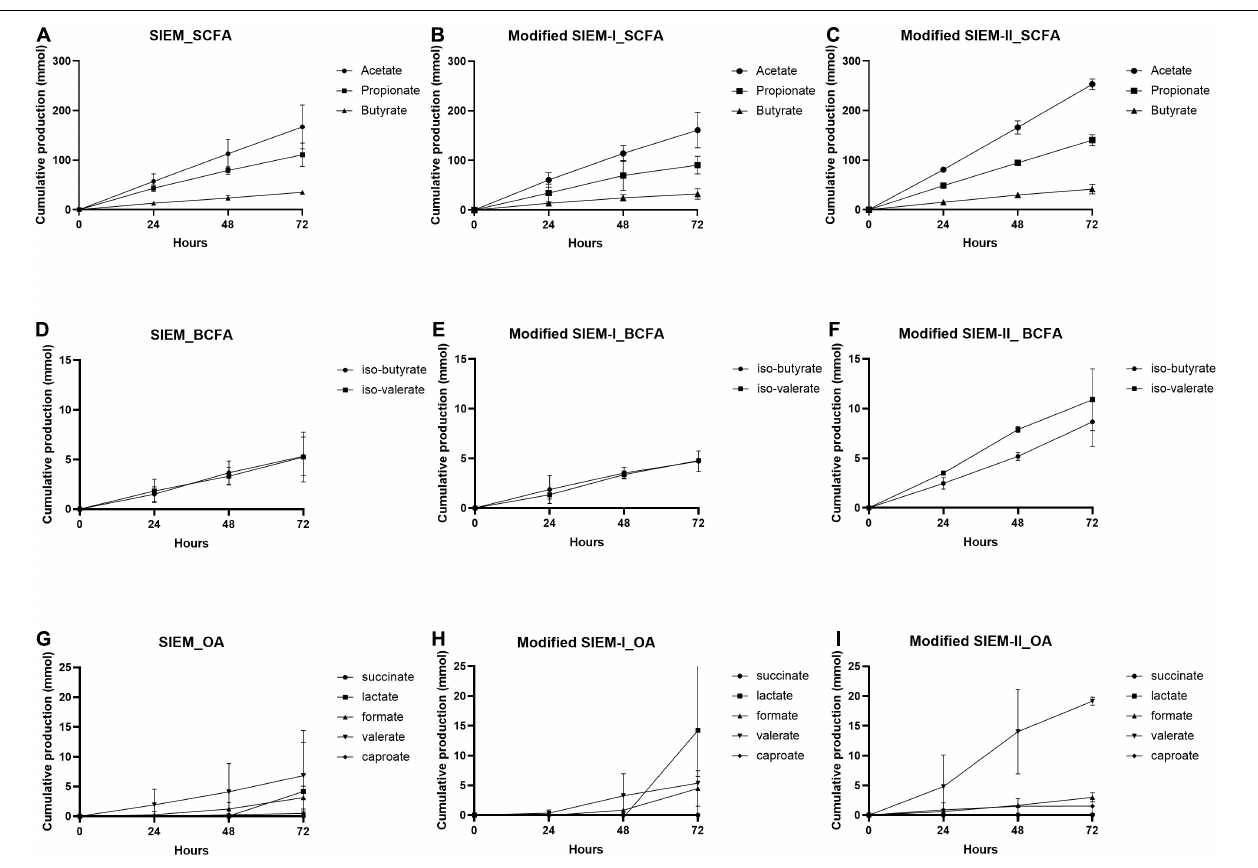
FIGURE 4 | Production of microbial metabolites over time. Cumulative production (in mmol) over time of short chain fatty acids (SCFA), branched chain fatty acids (BCFA) and other organic acids (OA). SIEM (A,D,G) , modified SIEM-I (B,E,H) and, modified SIEM-II (C,F,I) Data are presented as mean ( n = 2) ±